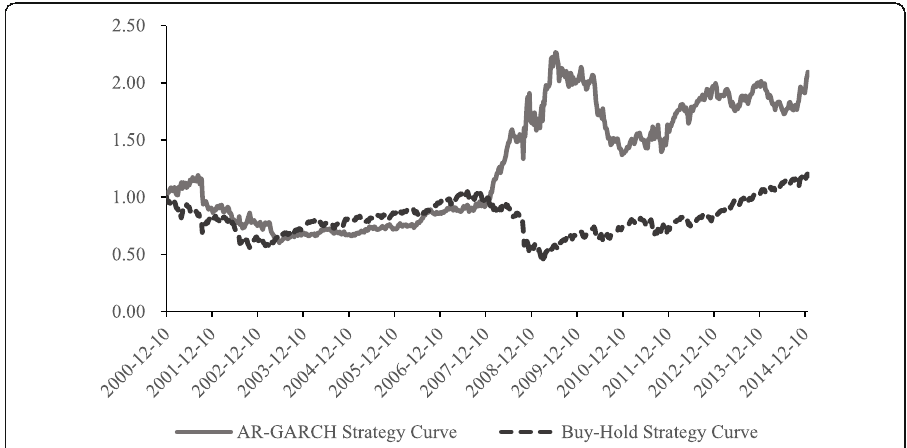
Fig. 7 The AR-GARCH strategy curve and the buy-and-hold strategy curve. The AR-GARCH strategy is not always effective. Its returns mainly occurred in the crisis period of 2008. During other periods, the strategy did not perform better than the buy-and-hold strategy. This means that the market is more efficient during ordinary times than during the crisis period. In the latter period, one can get excess returns in the inefficient